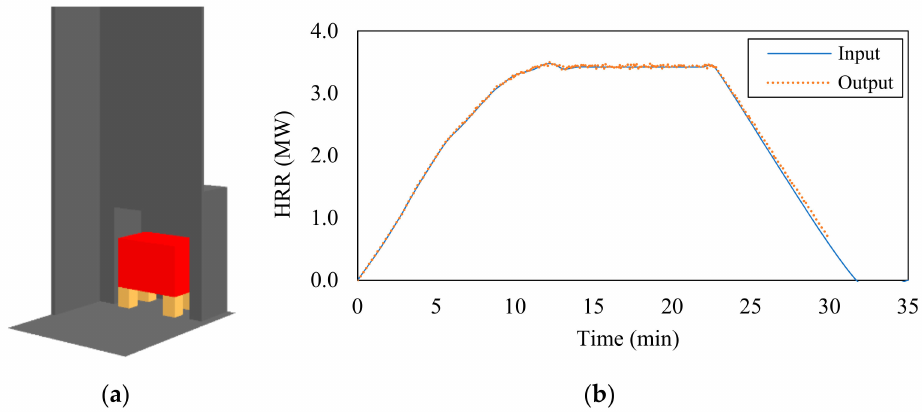
Figure 4. ( a ) Test setup with non-combustible wall (grey), wood crib (red), and ( b ) HRR verification for the BS 8414-1 wood